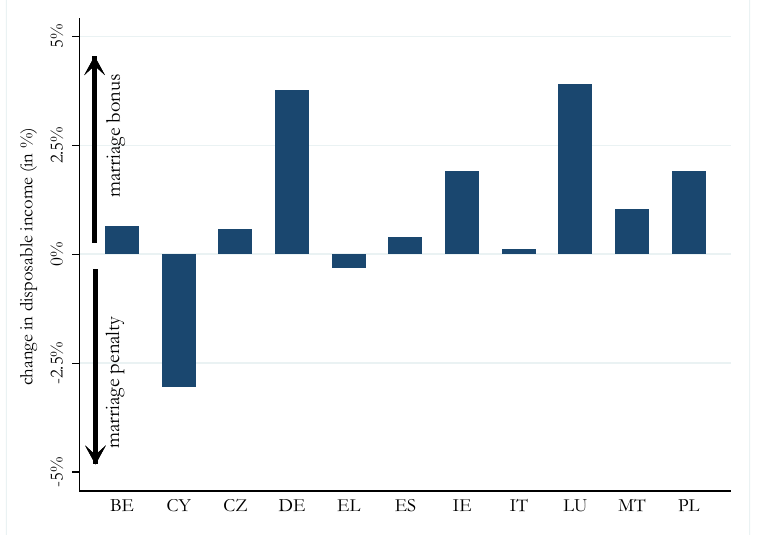
Figure 1. Marriage bonus or penalty for working-age households. Source: Christl et al. (2021). Economically significant marriage bonuses for working-age households (red bar) were identified in eight countries: Belgium, Czechia, Germany, Spain, Ireland, Luxembourg, Malta and Poland, while in Cyprus and Greece, there is a financial penalty for being married, therefore these two countries are excluded from our analysis. It is noteworthy that the marriage bonus is, on average higher for countries with joint taxation systems, such as Germany and Luxembourg (almost 4%), Ireland and Poland (about 2%, partly- joint